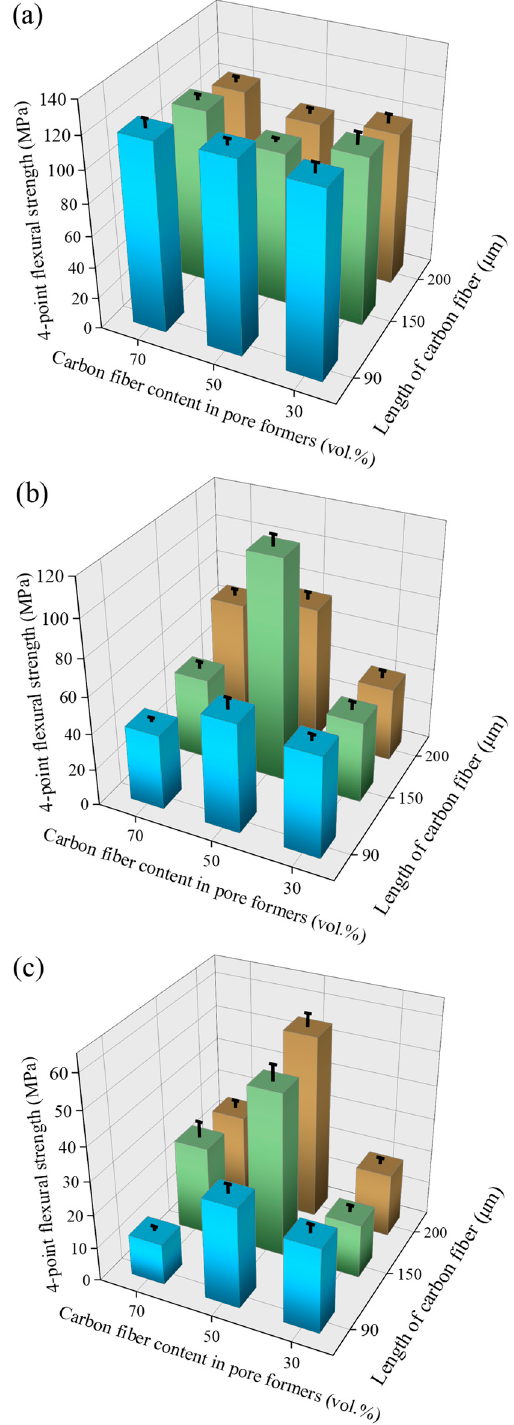
Figure 4. Flexural strength of porous alumina samples with different pore-forming agent contents. (The volume fractions of pore-forming agents are ( a ) 30 vol.%, ( b ) 50 vol.%, and ( c ) 70 vol.%).